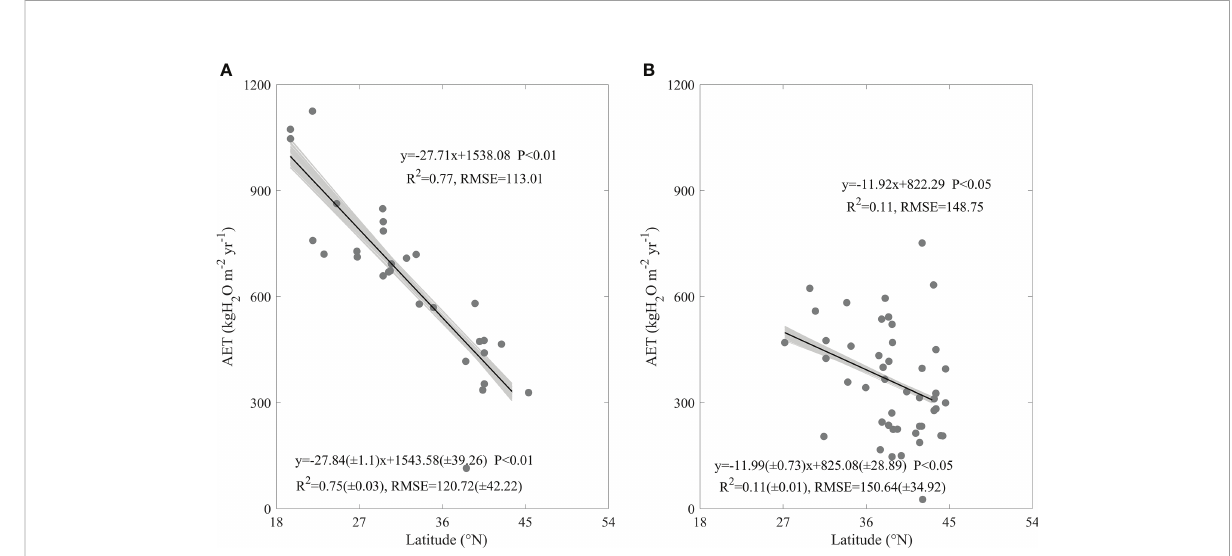
FIGURE 3 The annual evapotranspiration (AET) latitudinal patterns of forests (A) and grasslands (B) in China. The grey lines are regression lines generated from the random error adding AET, whose statistics are presented in the left bottom of each